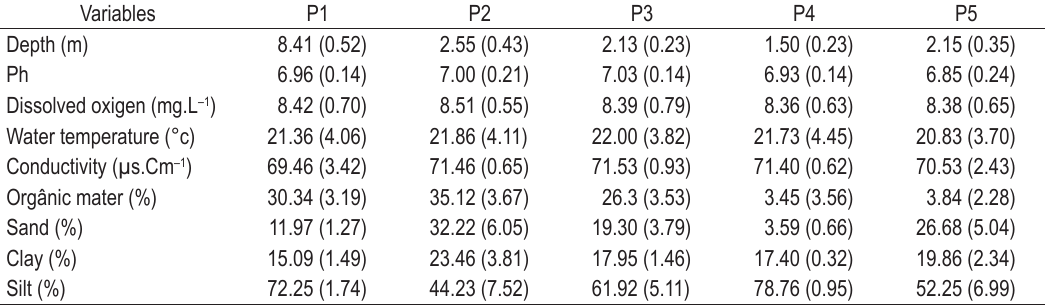
Table 1. Mean values and standard deviation (in parenthesis) of environmental variables of water and sediment measured at the five sites in Peri lagoon during the three samples